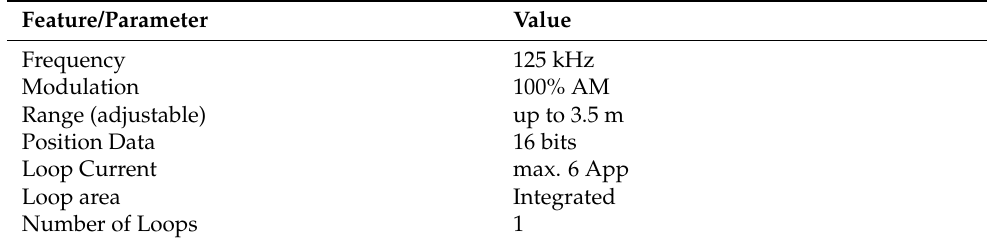
Table 7. Main features of the transponder and the active